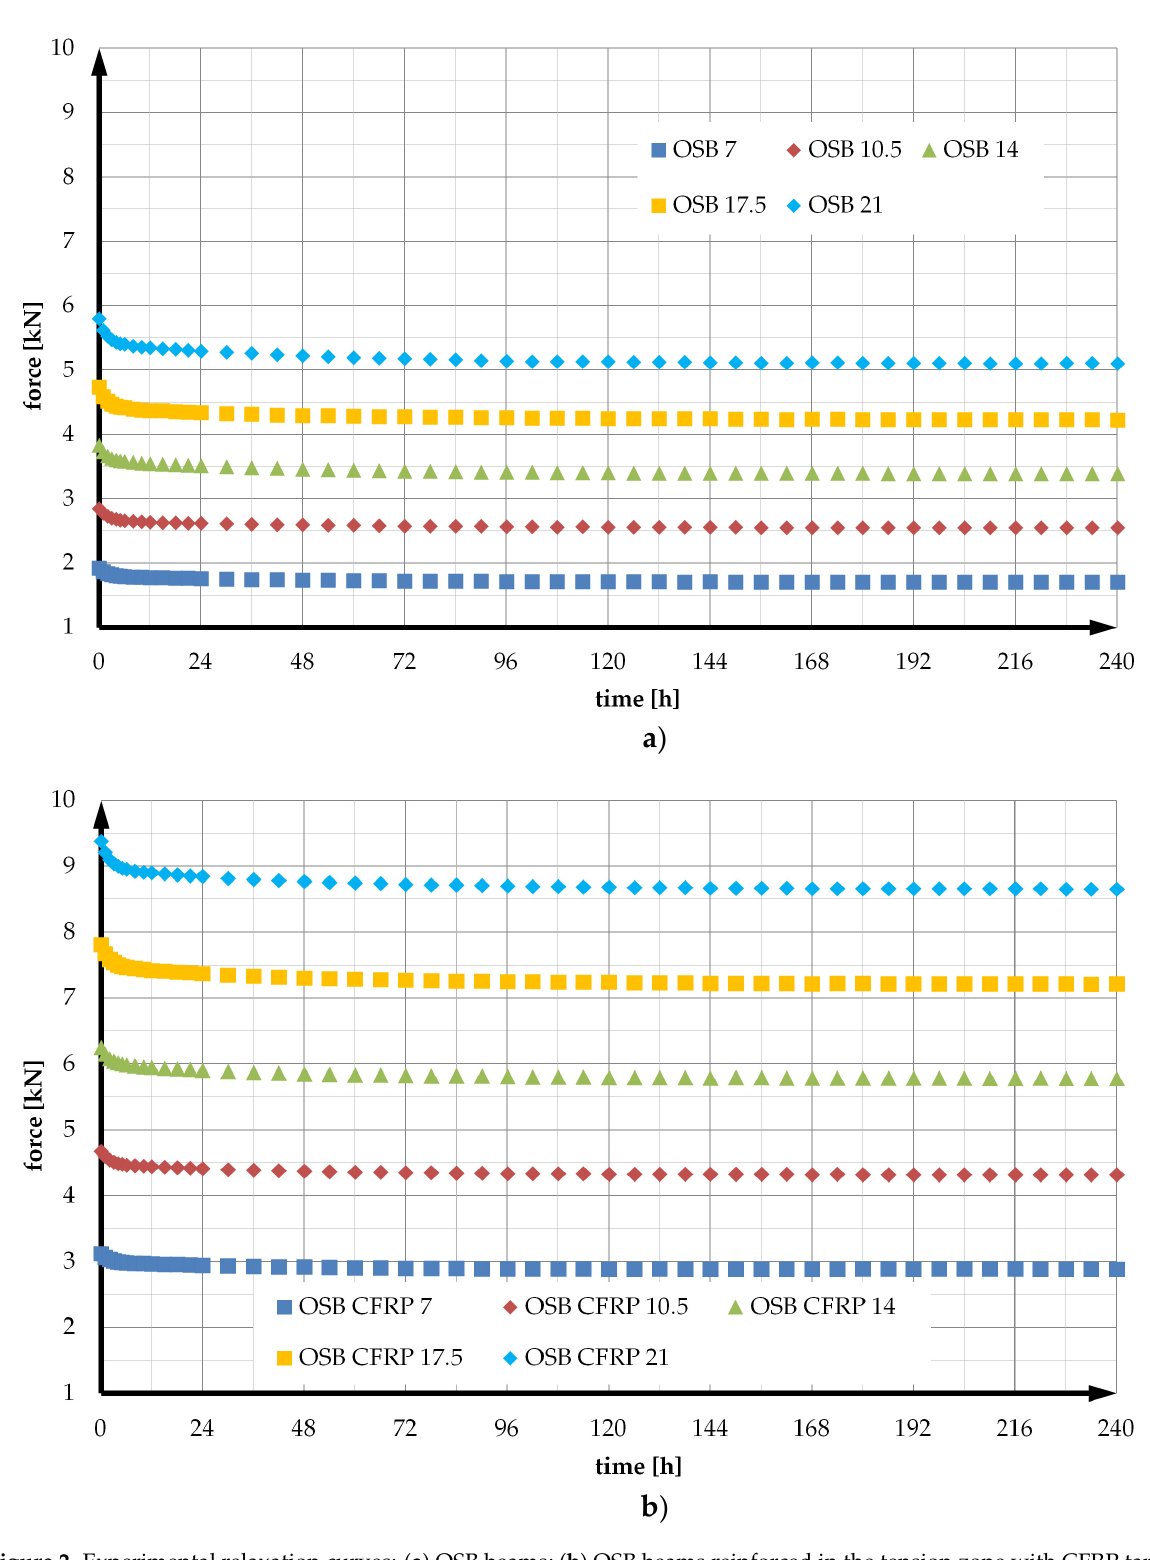
Figure 2. Experimental relaxation curves: ( a ) OSB beams; ( b ) OSB beams reinforced in the tension zone with CFRP tape.